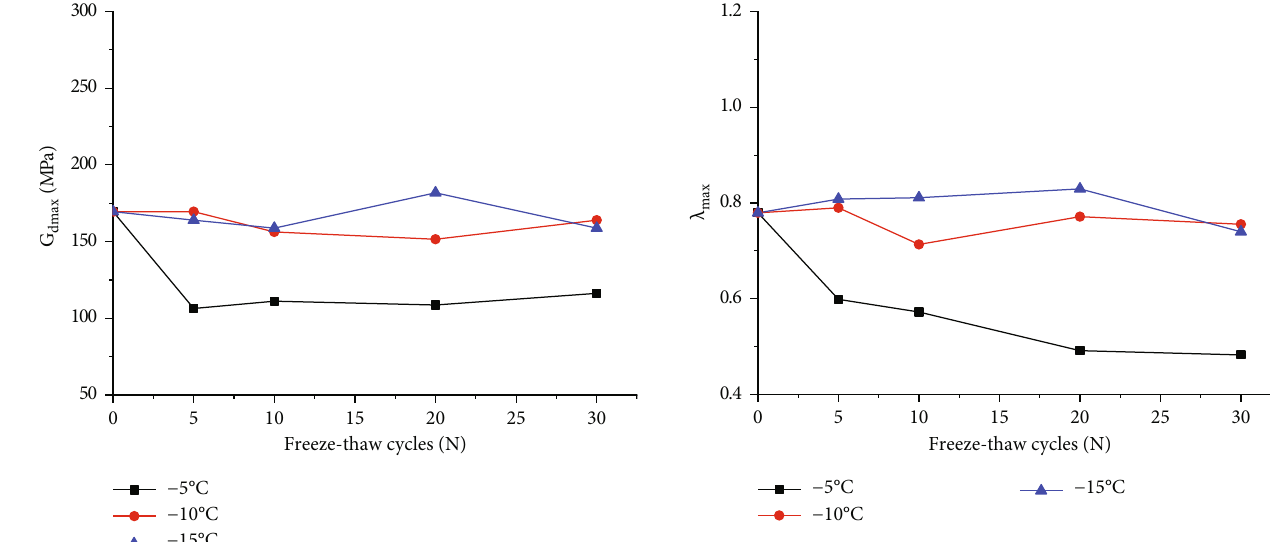
Figure 21: Curve of maximum damping ratio and freeze-thaw cycles at di ff erent freezing